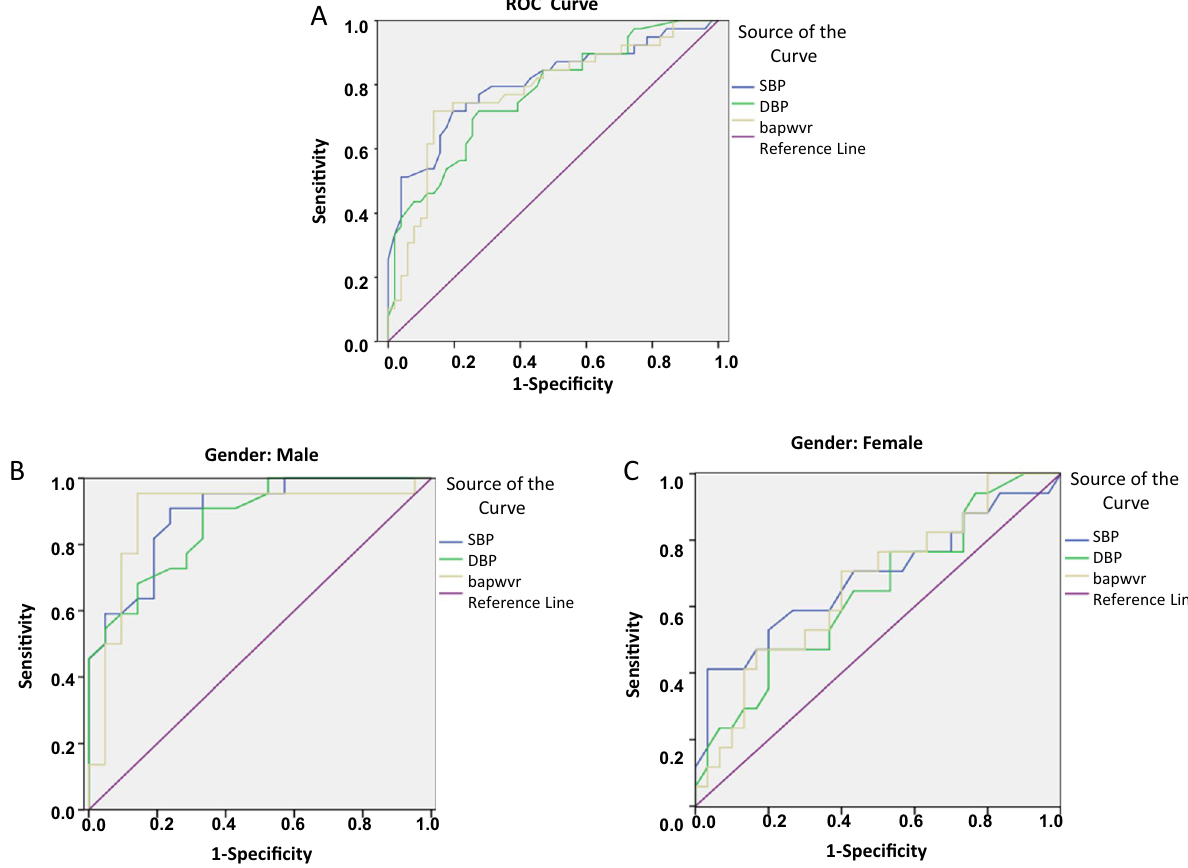
Figure 5. Receiver operating characteristic curves demonstrating OMA response to warm stimulation (HSD) in predicting BP and baPWV in all examiners ( A ), male group ( B ) and female group ( C ). Optimal cut off values for ( A ) is 9435.5 μm 2 , for ( B ) is 9485.5 μm 2 (male) and for ( C ) is 7631 μm 2